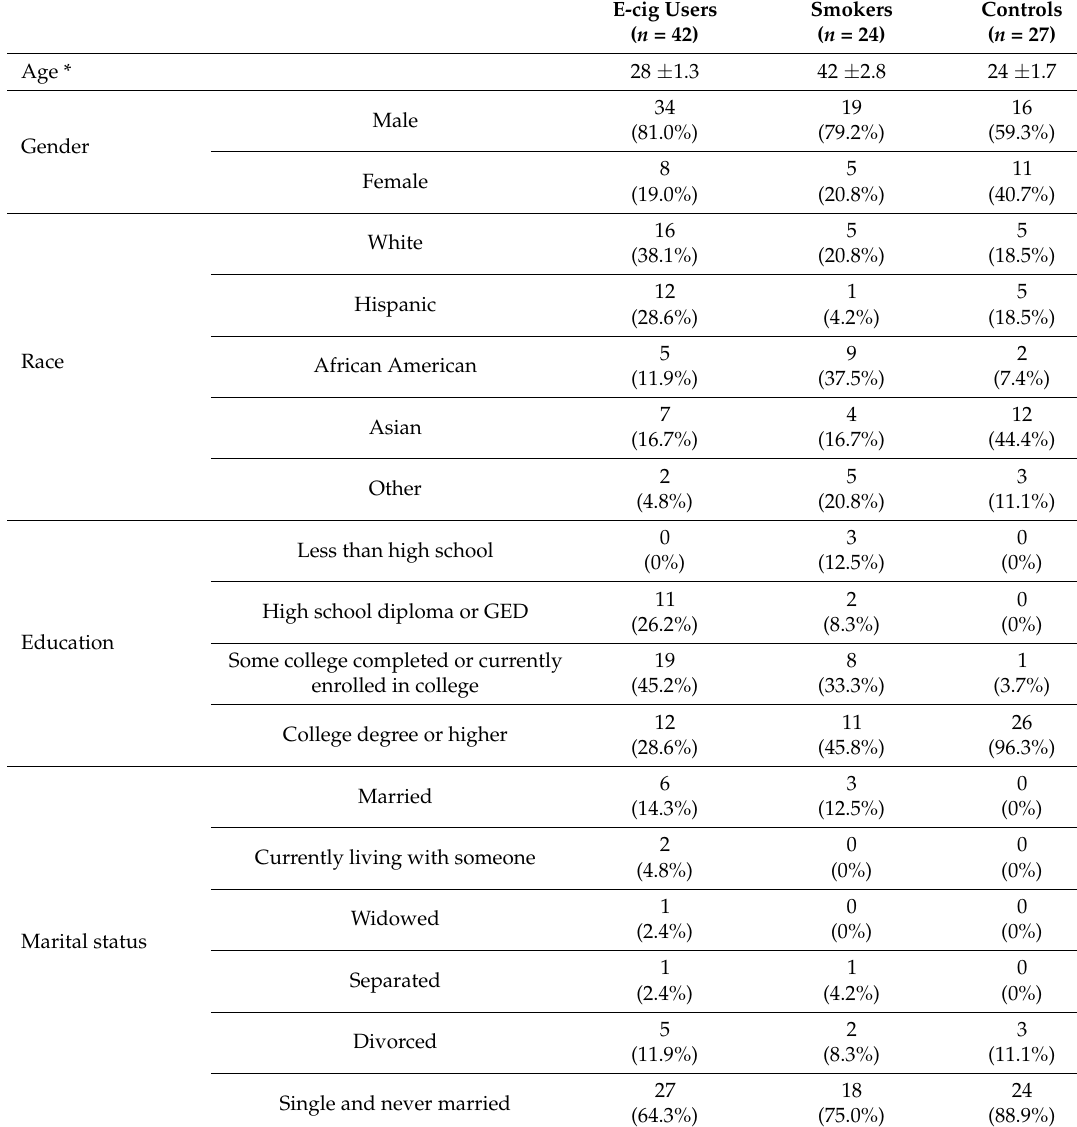
Table 1. Characteristics of the study